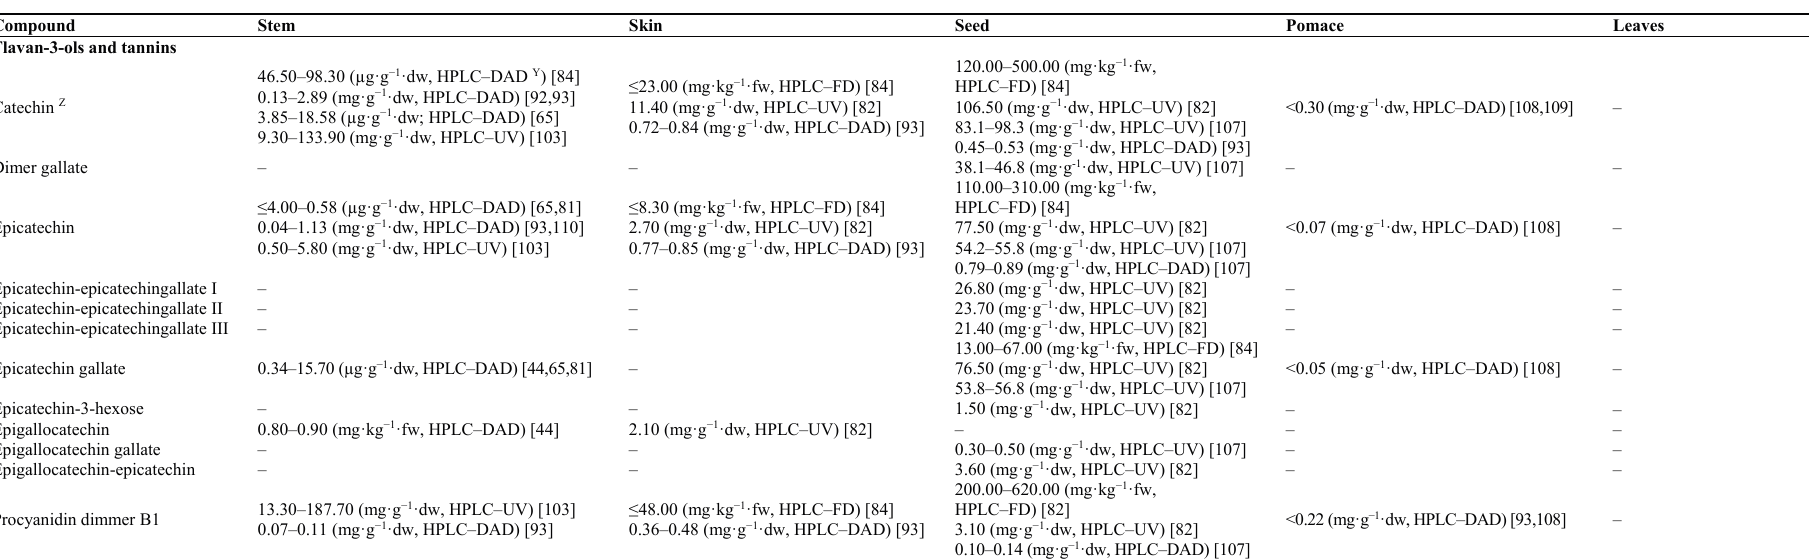
Table 4. Content in flavan-3-ols and tannins, flavones, and flavonols in winery residues of white varieties of Vitis vinifera